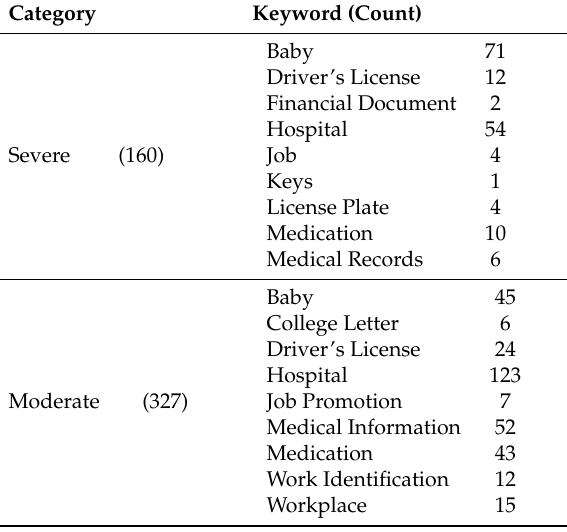
Table 14. Distribution of Content for Risk Categories. This table includes the keyword and the content